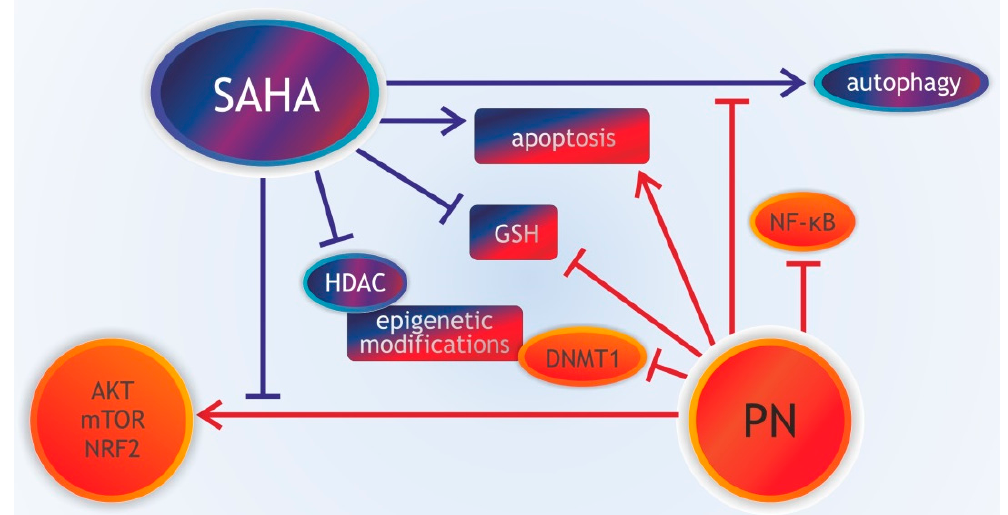
Figure 3. Schema summarizing synergistic effects of suberoylanilide hydroxamic acid (SAHA) and